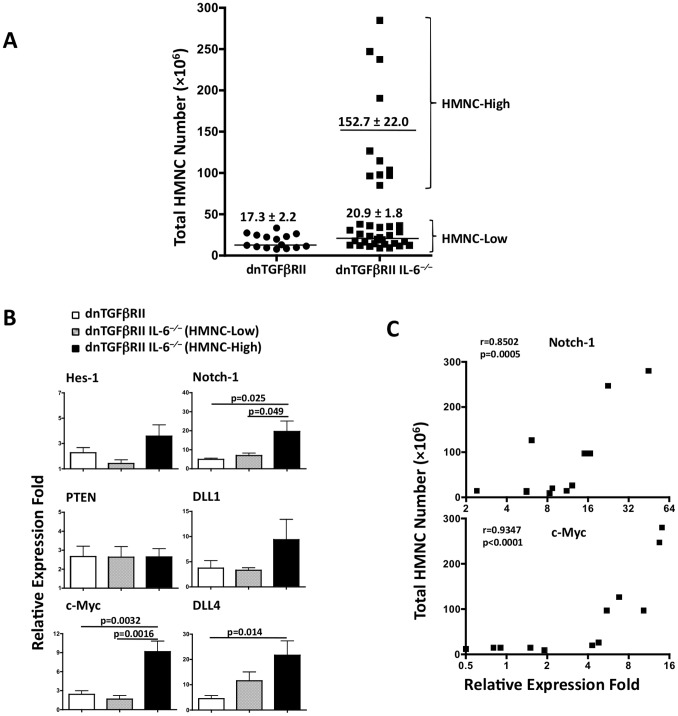
Lymphoma-like T cell infiltration developed in interbred dnTGFβRII IL-6−/− mice.A. Number of liver infiltrating HMNCs in interbred dnTGFβRII IL-6−/− mice in comparison with hemizygous dnTGFβRII mice. Data presented as Mean ± SEM; dnTGFβRII, n = 15; dnTGFβRII IL-6−/−, n = 37. B. The expression of Notch-1 and c-myc mRNA levels are significantly higher in livers of dnTGFβRII IL-6−/− mice with higher HMNC counts (HMNC-high) than dnTGFβRII IL-6−/− mice with lower HMNC counts (HMNC-low). Data presented as Mean ± SEM, n = 6. C. Spearsman correlation between HMNC counts and pro-oncogene expression.